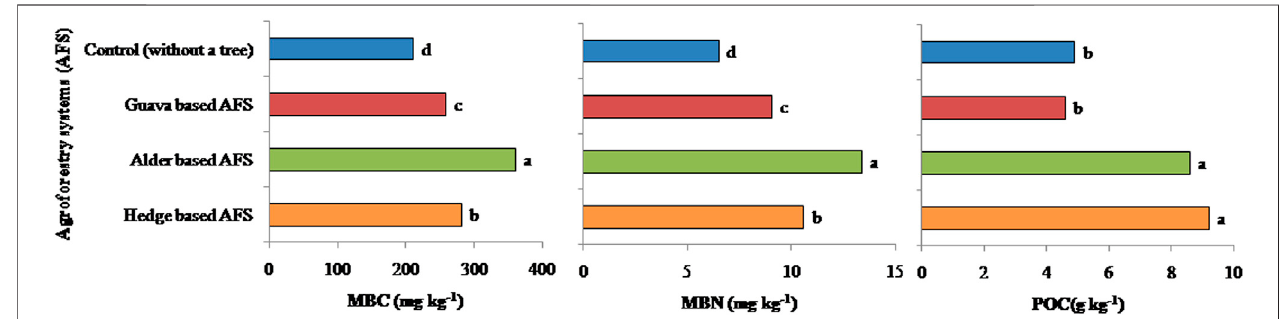
FIGURE 5 | Effect of various agroforestry systems on organic matter fractions in the soil depth 0 – 30 cm of the Indian sub-Himalayas. (MBC, microbial biomass carbon; MBN, microbial biomass nitrogen; and POC, particulate organic carbon. Means of different land use systems within a column followed by similar lowercase letters are not signi fi cant at p < 0.05 based on Tukey ’ s HSD test.)